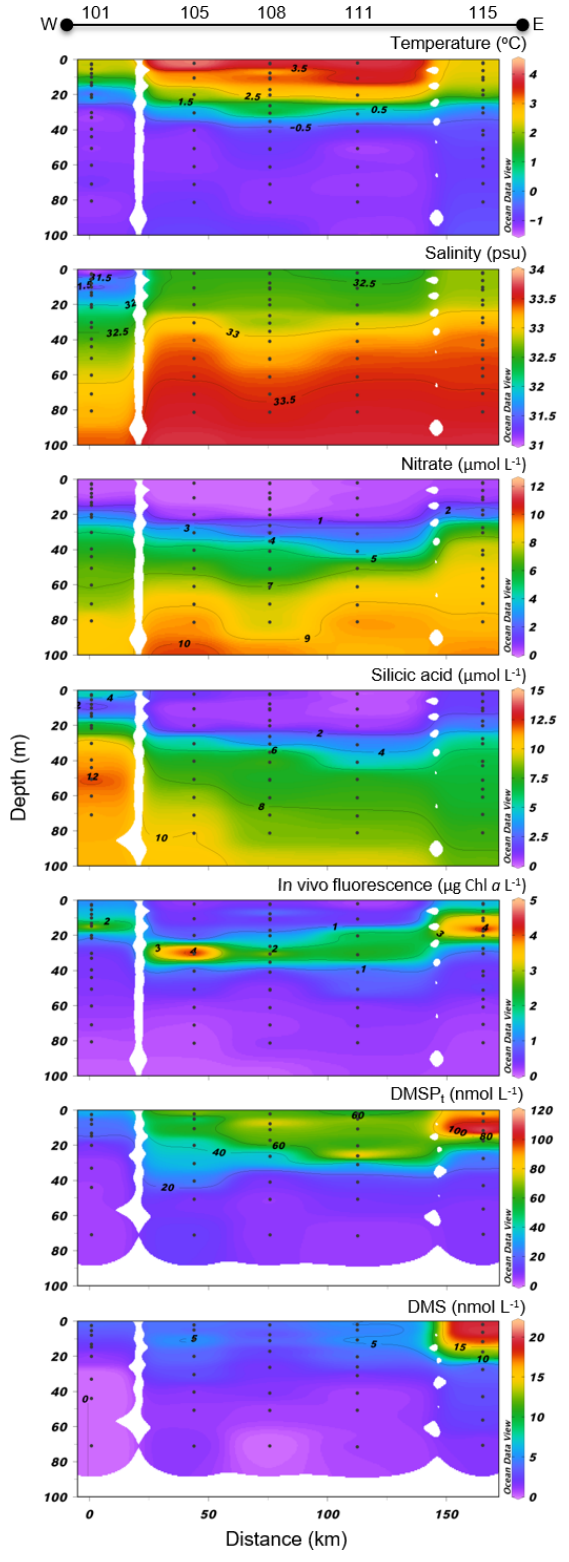
Figure 7. North Water (NOW) cross section of the vertical distri- butions of temperature, salinity, nitrate, silicic acid, in vivo fluores- cence, DMSP t , and